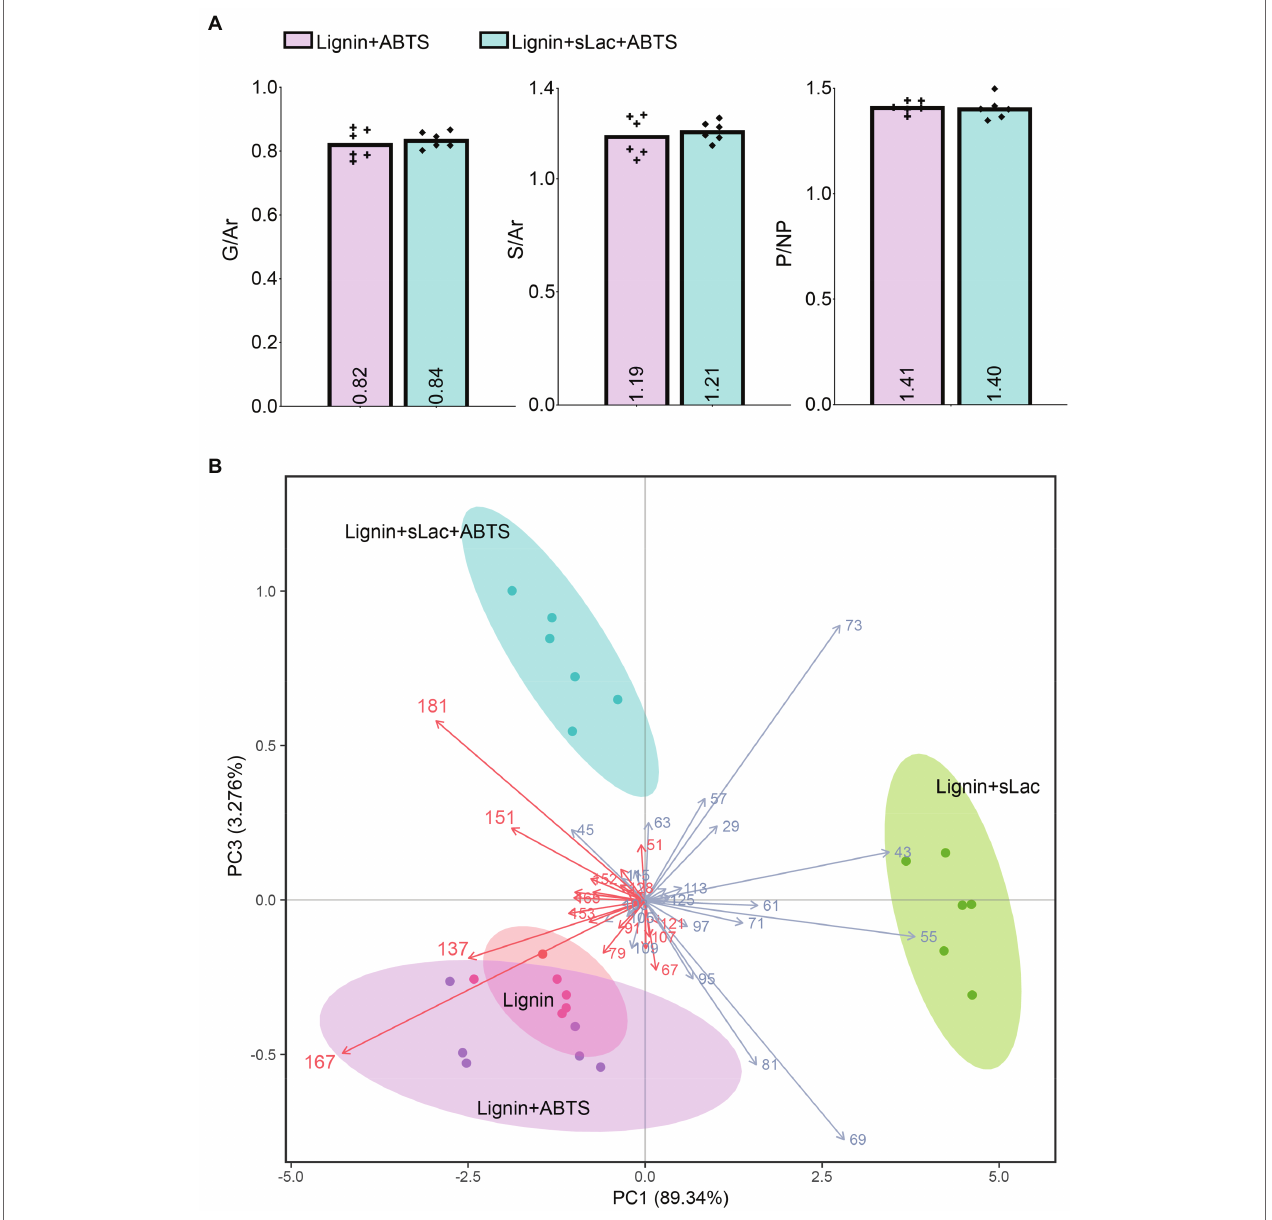
FIGURE 4 | Effect of ABTS on sLac activity on organosolv lignin. (A) G/Ar, S/Ar, and P/NP ratios: Data are shown as dots and their averages are reported as bar charts as well as numbers inside columns. (B) PCA analysis: The numbers on the top of arrows indicate m/z values, those annotated as lignin are highlighted in red. The arrows demonstrate the influence of m/z values in sample clustering. Ellipses represent 95% confidence of sample distribution, colored dots are ToF-SIMS acquisition data ( n =